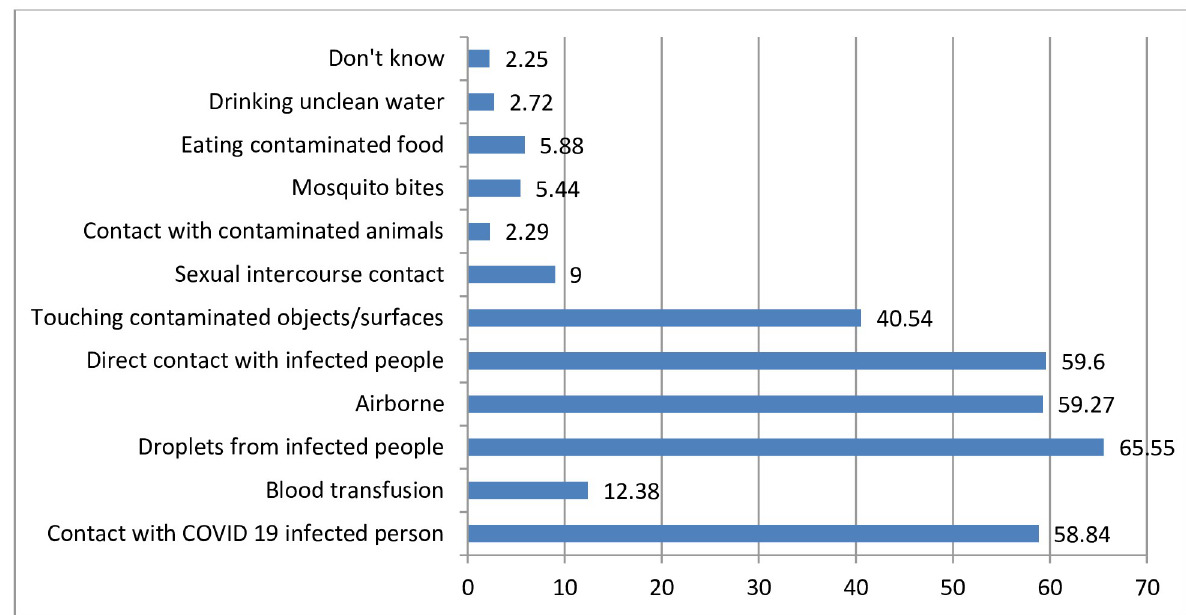
Fig 7. Percentage of respondent’s perception on the transmission of COVID-19, Oromia region, Ethiopia, September 2020 to March 2021. NB: Percentage may not add 100% as multiple responses were possible.